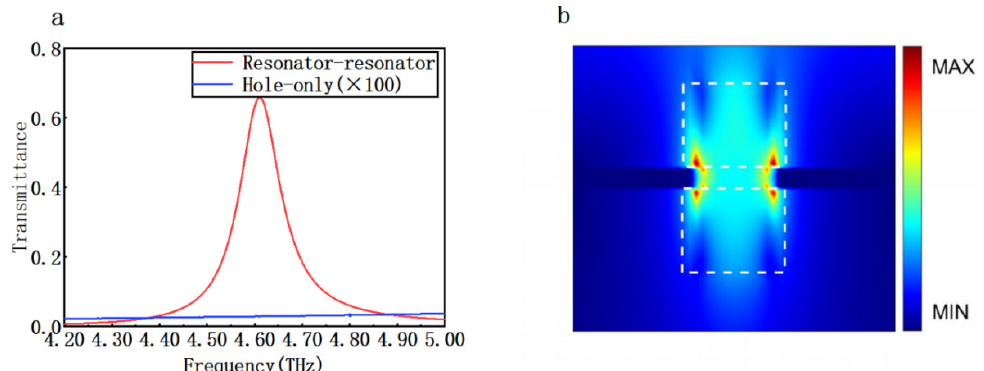
Figure 2. ( a ) The transmittance characteristics of the EEOT structure (Resonator-resonator structure) and Hole-only structure, when Au film thickness is 1 µ m, and length and width are both 50 µ m. The hole radius is 4.5 µm. The silicon particle height h 0 is 4 µm, and width w 0 and length l 0 are both 12 µm. ( b ) Electric field intensity distribution diagram. The red and yellow parts are at the edges of the metal array hole. The white dotted lines show the position of the silicon particles.